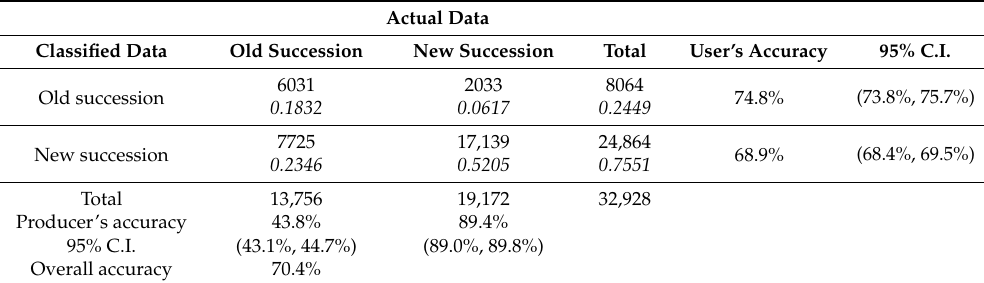
Table 2. Confusion matrix based on number of samples and per class statistics for old and new succession. The Actual data represent the real (vectorized) occurrence of successional vegetation. The counts from the confusion matrix are shown in roman type, and the proportions from the corresponding proportions matrix are shown in in italics.